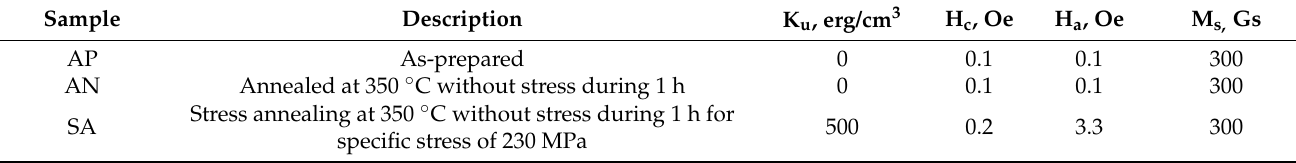
Table 1. Description of the types and states of rapidly quenched Fe 3 Co 67 Cr 3 Si 15 B 12 ribbons and conditions of their thermal treatments. Selected parameters, obtained for long samples of 45 mm: